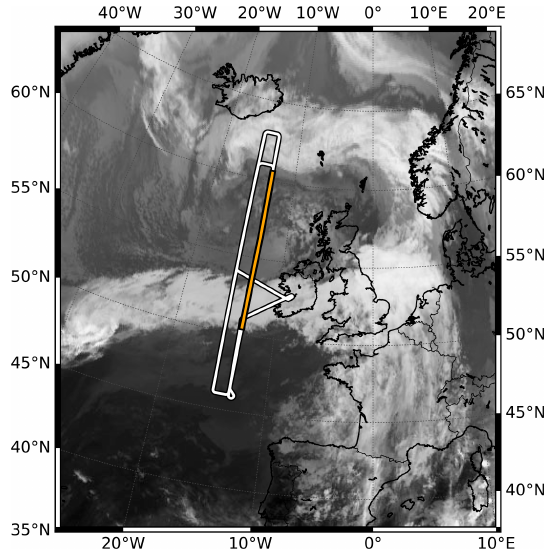
Figure 2. Meteosat SEVIRI infrared satellite image (10.8µm) for 1 October 2017 at 18:00UTC superimposed by the HALO flight track (12:05–21:57UTC; thick black line) and the subsection from 18:40 to 20:00UTC (orange line). Copyright 2020